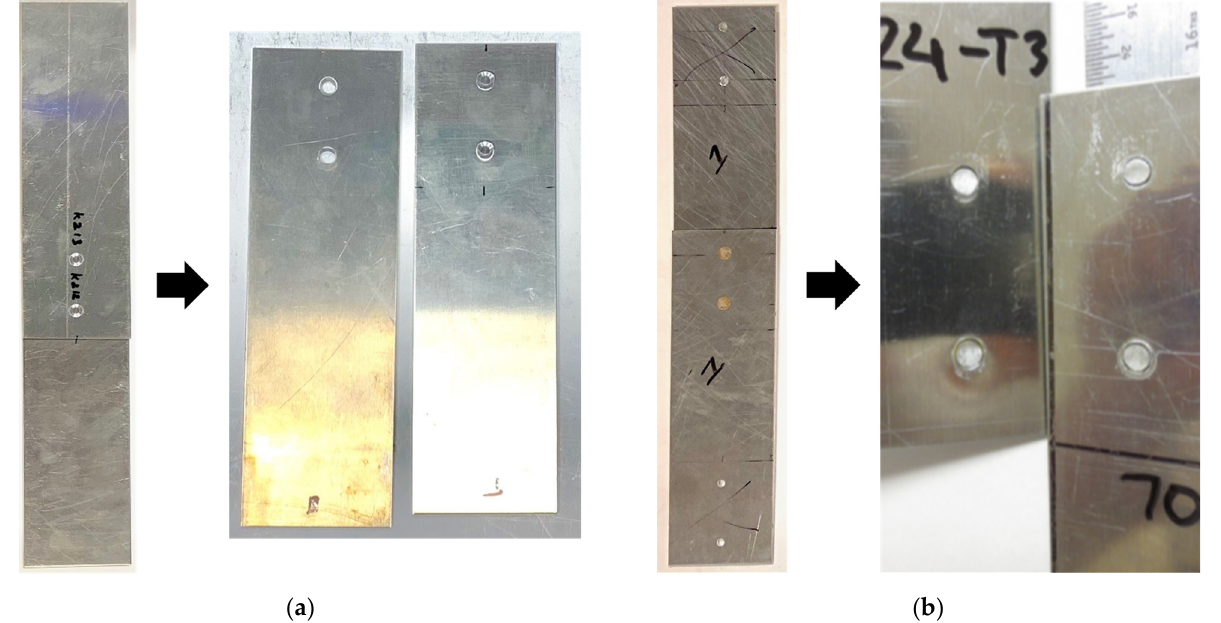
Figure 9. Two-spot coupons before and after static load lap shear tests: ( a ) 2-refill-spot-weld coupon ( left ) and nugget pullout failures ( right ); ( b ) 2-rivet-joint coupon ( left ) and rivet shear failures ( right ). The image of the nugget pullout failures shows the faying surfaces of the stiffener and skin pieces. The image of the rivet shear failures also shows the faying surfaces of the skin and stiffener pieces. The images may have different scaling for clarity.